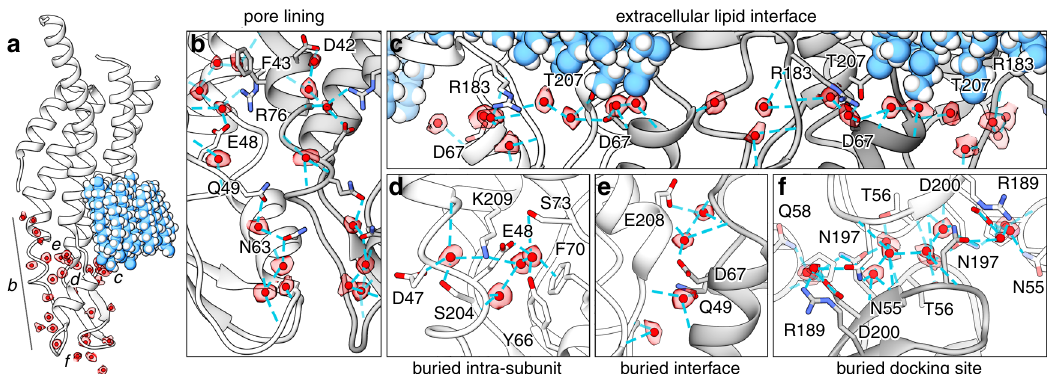
Fig. 2 Ordered water molecules resolved in Cx46/50 by CryoEM. a Cx46/50 subunit with segmented CryoEM density of waters overlaid in transparency (colored as in Fig. 1). Labels in a indicate position of the various zoom views, presented in b – f , showing water molecules bound to b pore-lining sites, c extracellular lipid interface, d buried intra-subunit sites, e buried subunit interface sites, and f buried cell-to-cell docking sites. In b – f , amino-acid sidechains forming hydrogen bonds to water are displayed (blue dashed lines) and labeled using Cx50